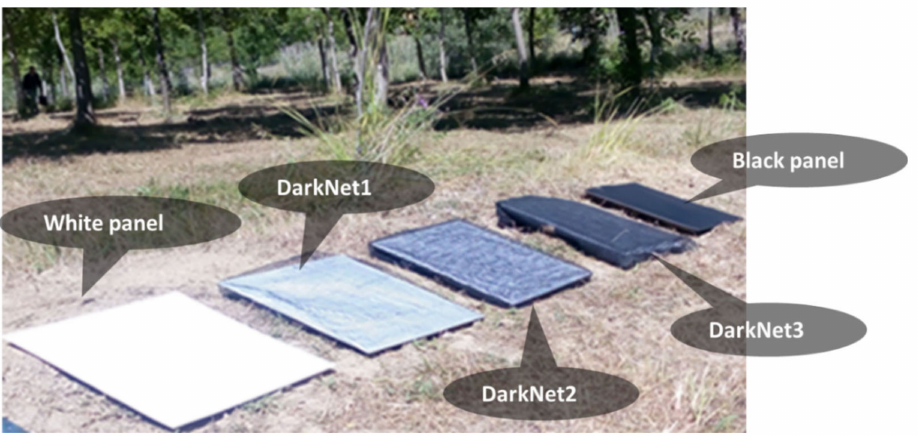
Figure 2. The validation targets in the agricultural field in Alento,